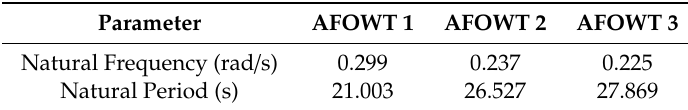
Figure 5. Response amplitude operators (RAOs) of articulated offshore wind turbines (AOWTs). Table 4. Natural features of the AOWTs.